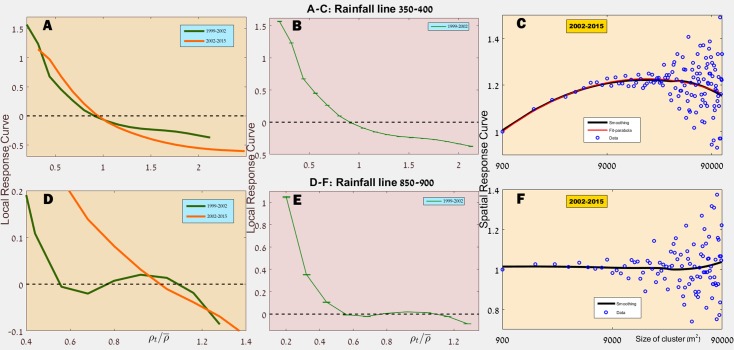
LRC and SRC for specific rainfall lines.The date for 350-400 mm/year region (panels A-C) exemplify the typical scenario, where the LRC (panel A and with error bars in panels B and E) decreases monotonously with density. On the other hands, in panel D one notices that the 1999-2002 line appears to indicate positive feedback. This is a rare exception (see S3 Fig), the apparent positive feedback disappears in the 2002-2015 interval. Panel C shows a typical SRC curve, while in panel F the curve is almost flat; this flat curve is, again, an exception, as seen in S1 and S2 Figs. The details of the smoothing and fitting procedures are given in the Text B in S1 Appendix.